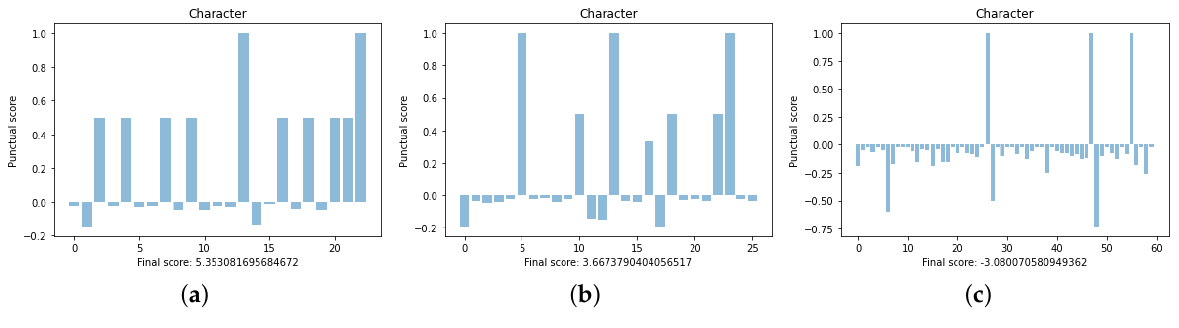
Figure 6. A bar graph of the scores of the strings: